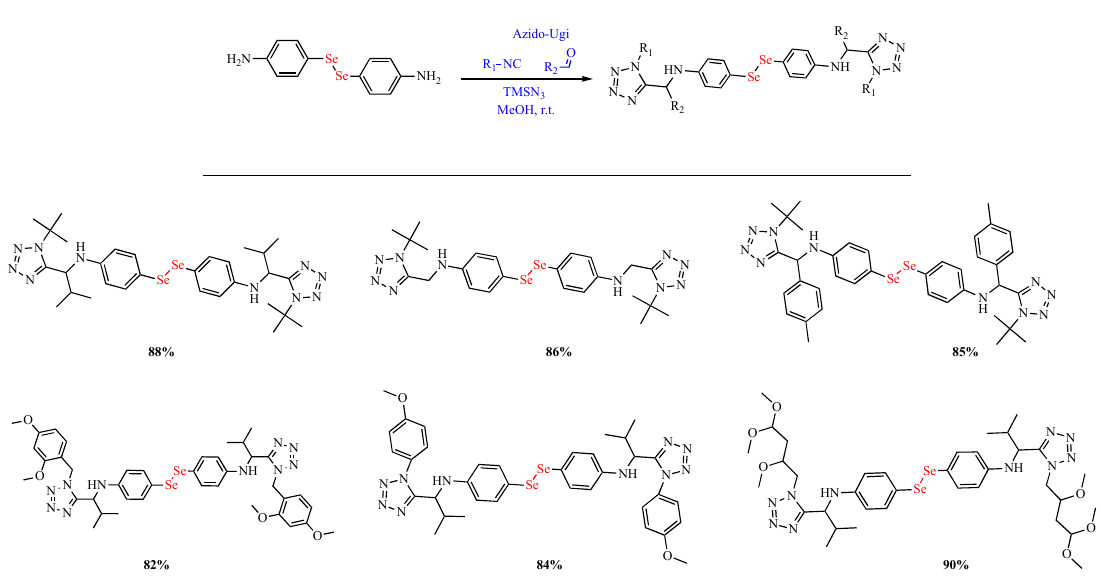
Scheme 36. Synthesis of tetrazole-based symmetrical diselenides and selenoquinones